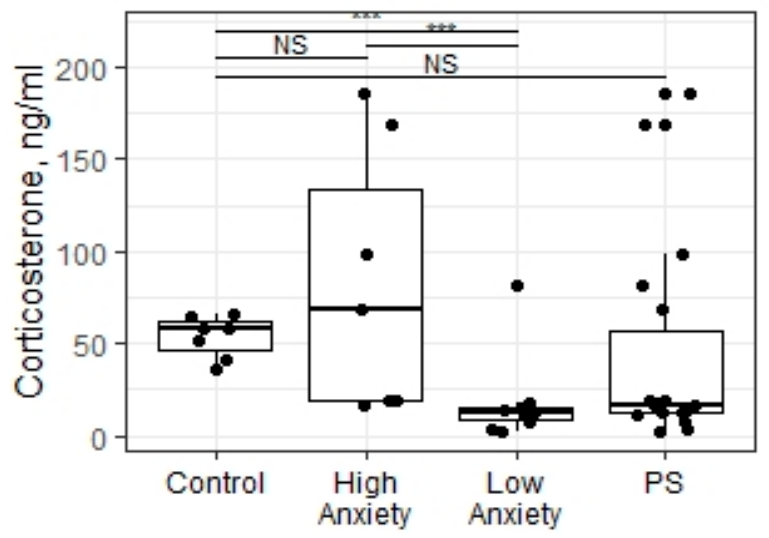
Figure 1. Plasma CORT concentrations (ng/mL) in PSS rats segregated into high- and low-anxiety groups according to AI as determined by performance in the EPM. Differences in plasma CORT concentrations among groups are shown as boxplots with dots representing individual data values and medians shown by horizontal lines. The boxes include the central 50% of the data, i.e., from the 25th to the 75th percentile. The whiskers include the data contained within 1.5 times the interquartile range. NS = p > 0.05; * p < 0.05; ** p < 0.01; *** p < 0.001. p values determined in non-parametric